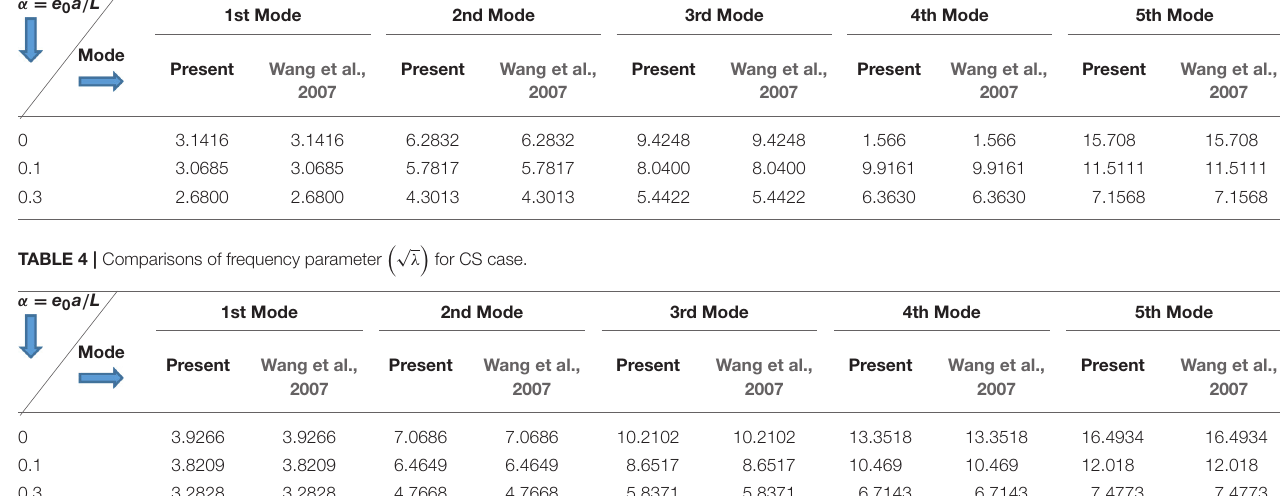
TABLE 5 | Comparisons of frequency parameter α = e 0 a / L